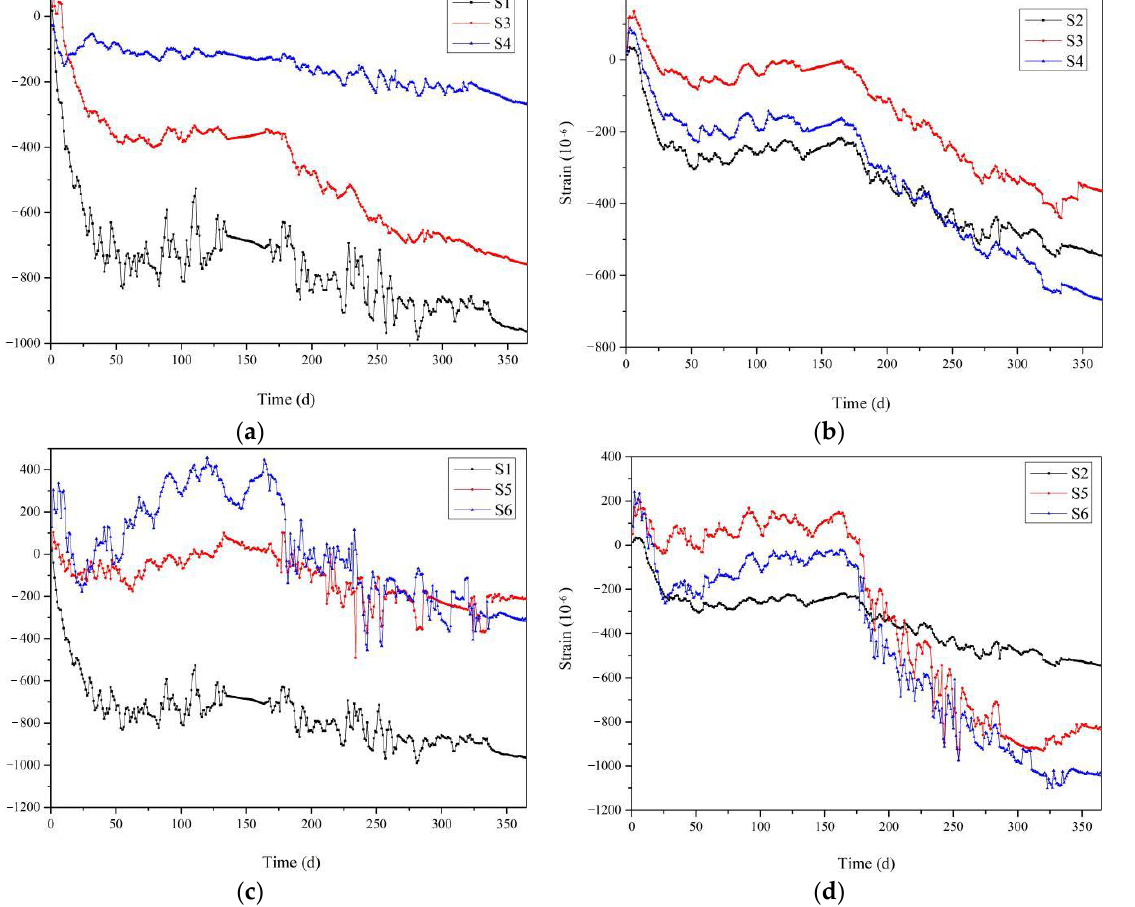
Figure 11. Strain curves of wall panels with different types of interfaces: ( a ) GRC strain curves of S1, S3, and S4; ( b ) PC strain curves of S2, S3, and S4; ( c ) GRC strain curves of S1, S5, and S6; ( d ) PC strain curves of S2, S5, and S6.